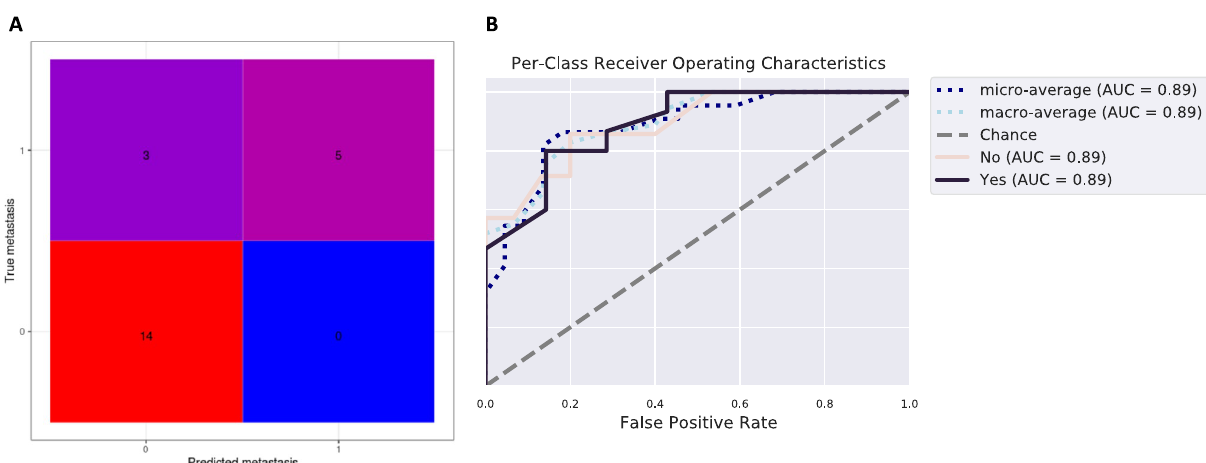
Figure 6. Prediction of altered KEGG pathways using PICRUSt2 analysis. A total of six KEGG pathways were significantly different between the metastasis and no metastasis groups. Bar plots on the left side display the mean proportion of each KEGG pathway. Dot plots on the right show the differences in mean proportions between the two indicated groups using P-values.